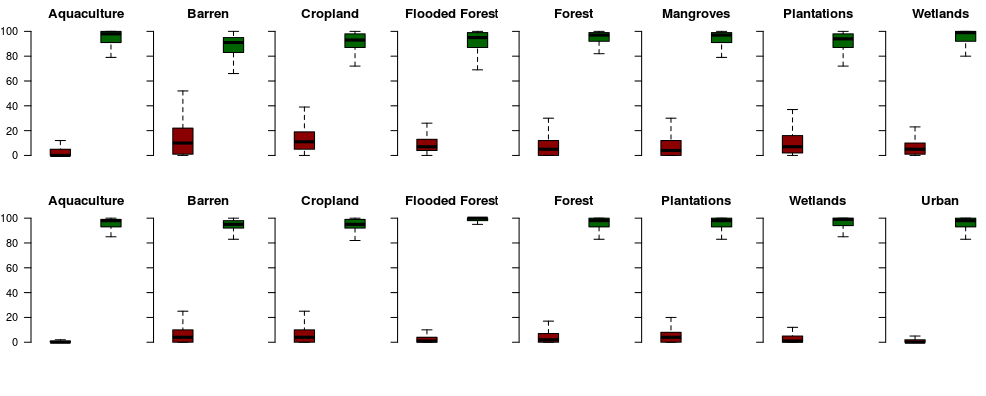
Figure 3. Distributions of the training data samples for ‘Specific to Generic’ (top row) and ‘Generic to Specific’ (bottom row). The red boxes show change probabilities of pixels that did not change, the green boxes for the change pixels.